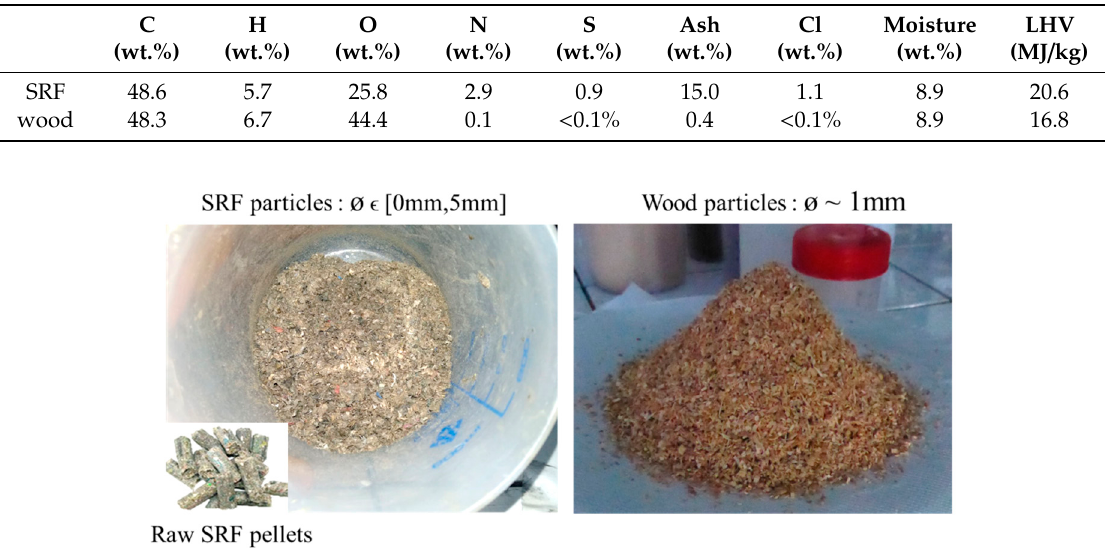
Figure 2. SRF and wood samples preparation.